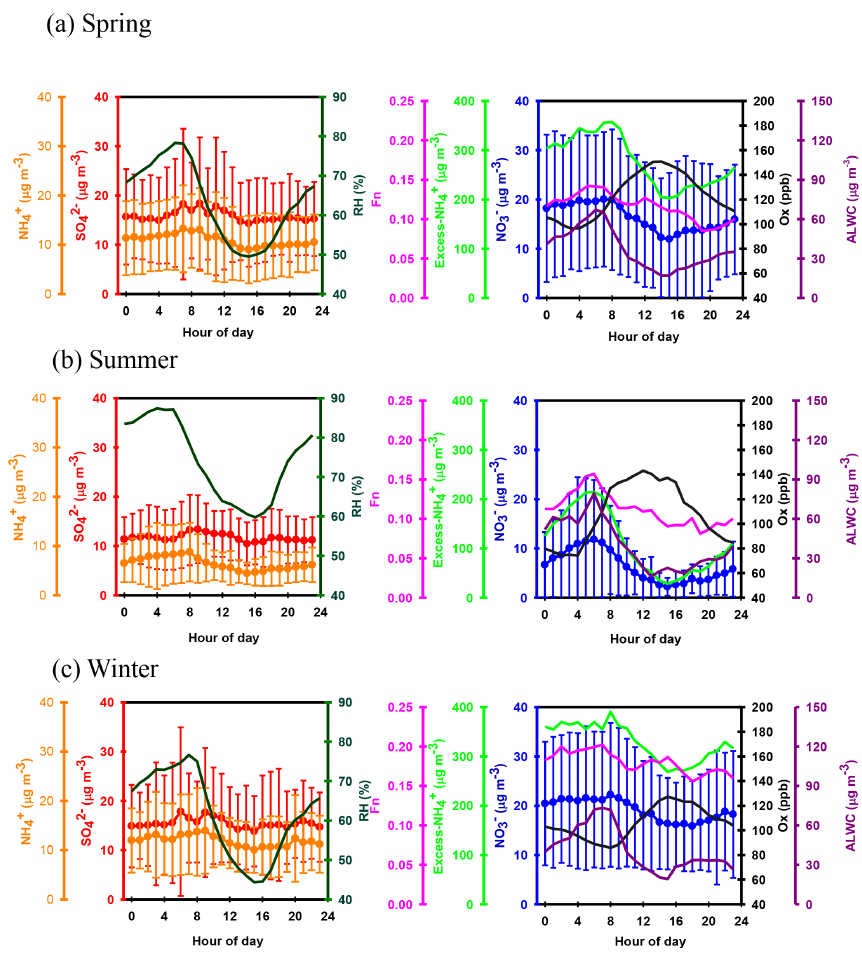
Figure 3. Diurnal variations in the concentrations of NO − ( F n ) and ambient relative humidity in Nanjing during the sampling periods. For SO 2 − deviations (solid lines) are plotted.